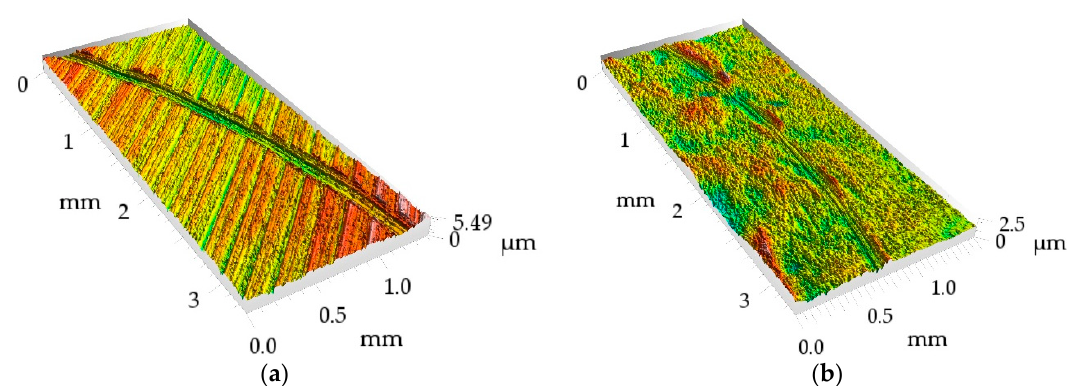
Figure 8. Isometric view of the milled surface ( a ) and of the burnished surface with a pressure of 20 MPa ( b ) after tribological tests at the normal load of 30 N.